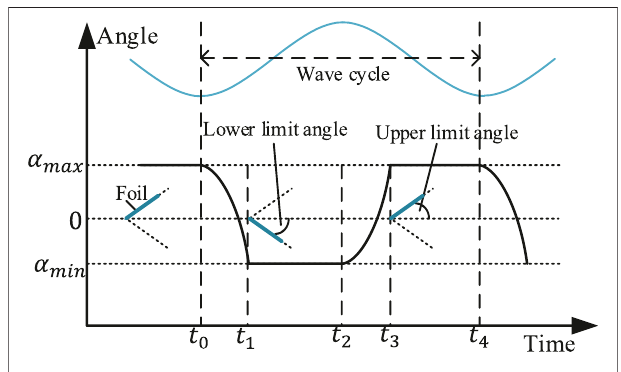
FIGURE 1 | The movement of a foil in a wave cycle ( t 0 to t 4